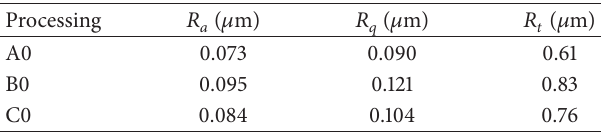
Table 2: The surface roughness of Ti-153 sheet specimens after various processing. Processing